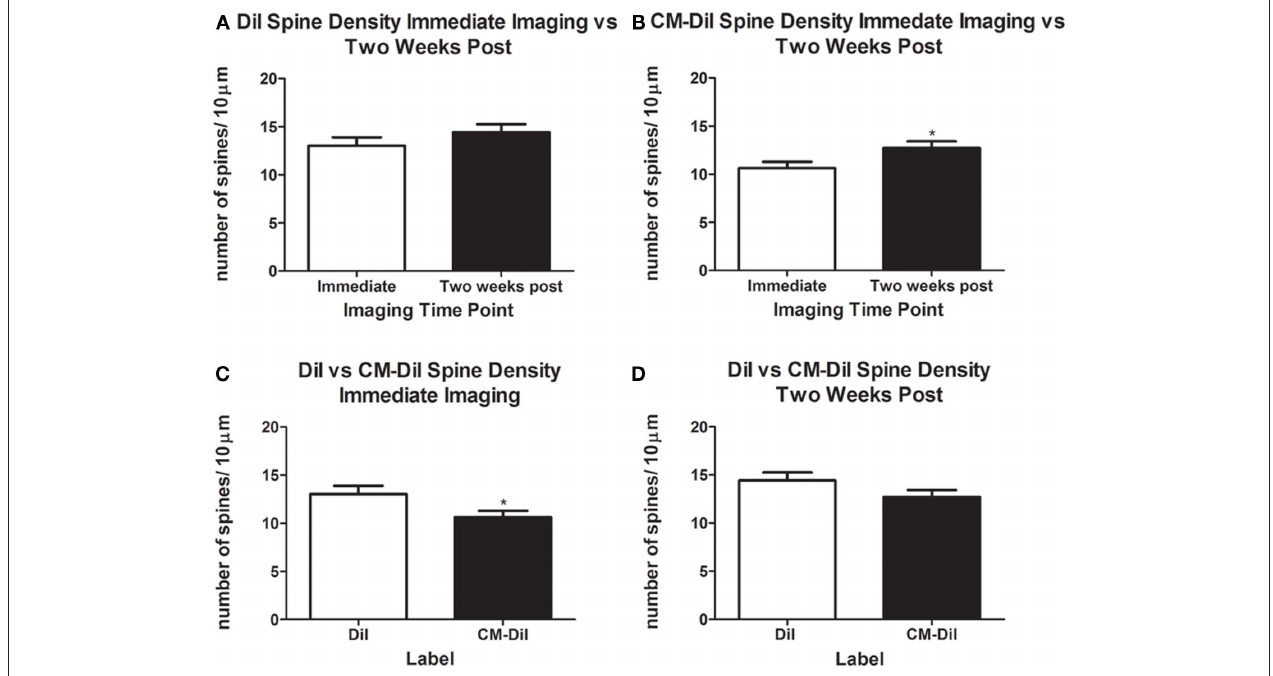
immediately (* p < 0.05). (C) Non-permeabilized CM-DiI treated tissues had a significantly lower spine density than non-permeabilized DiI treated tissue